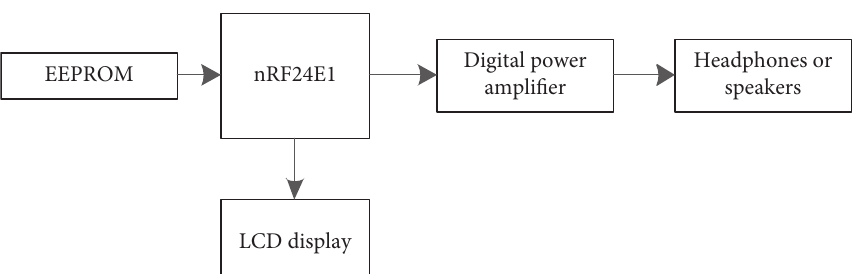
Figure 2: Communication principle of nRF24E1 transceiver chip.